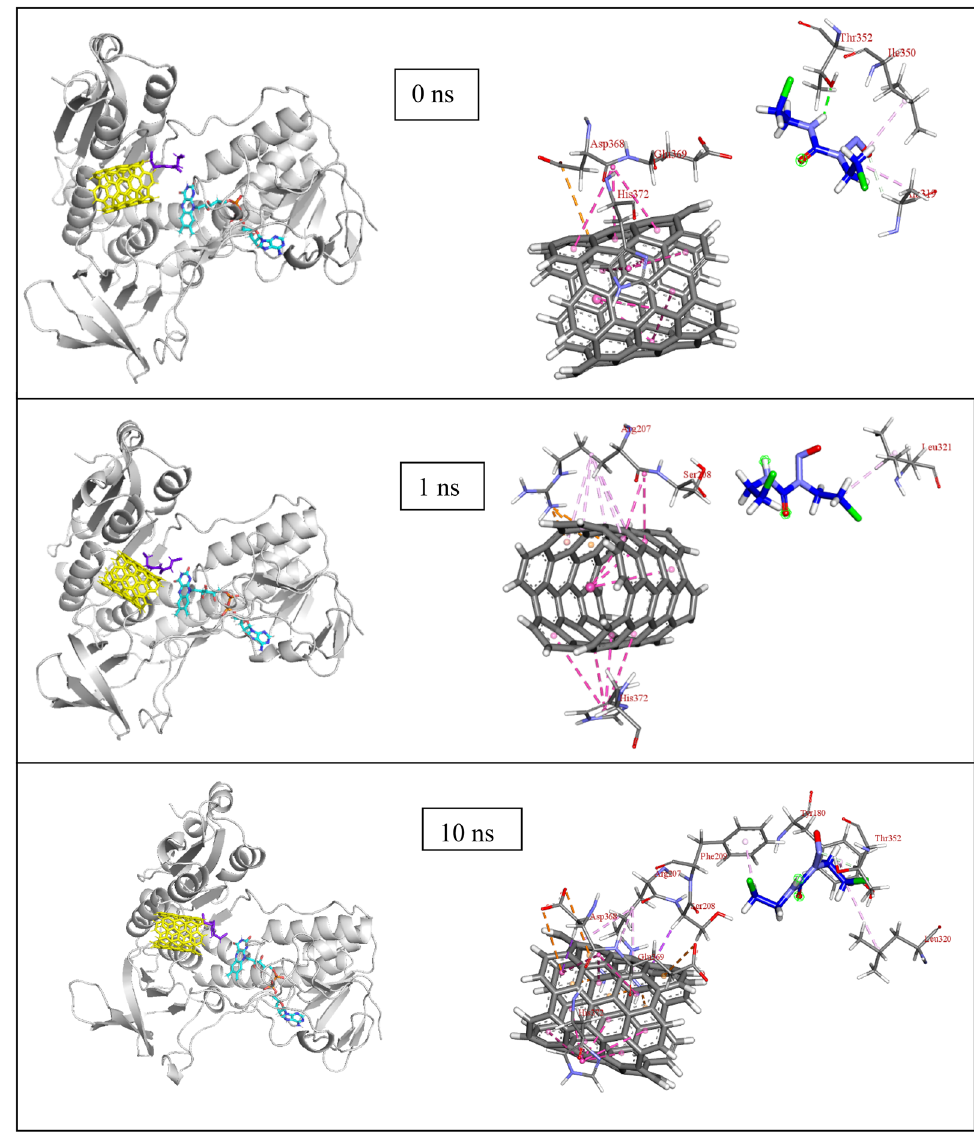
Figure 7. ( a ) Snapshot of MD results (shown at an interval of 10 ns) with fixed axis at each time step ( b ) Interacting atoms of GR with Carmustine and SWCNT at the binding